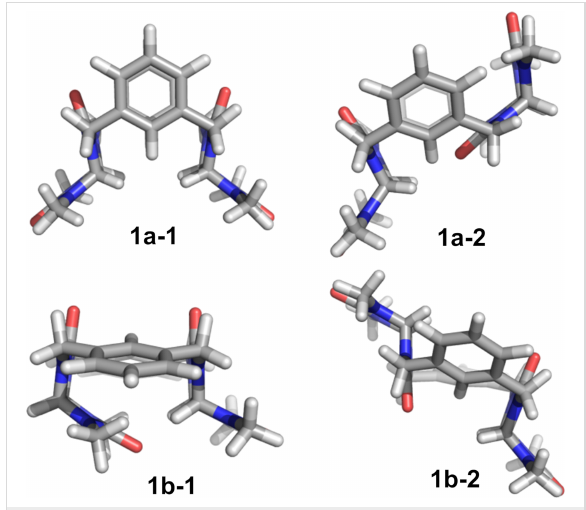
Figure 2: Conformers of macrocycles 1a , 1b optimized at the CAM- B3LYP/6-31G(d) level of